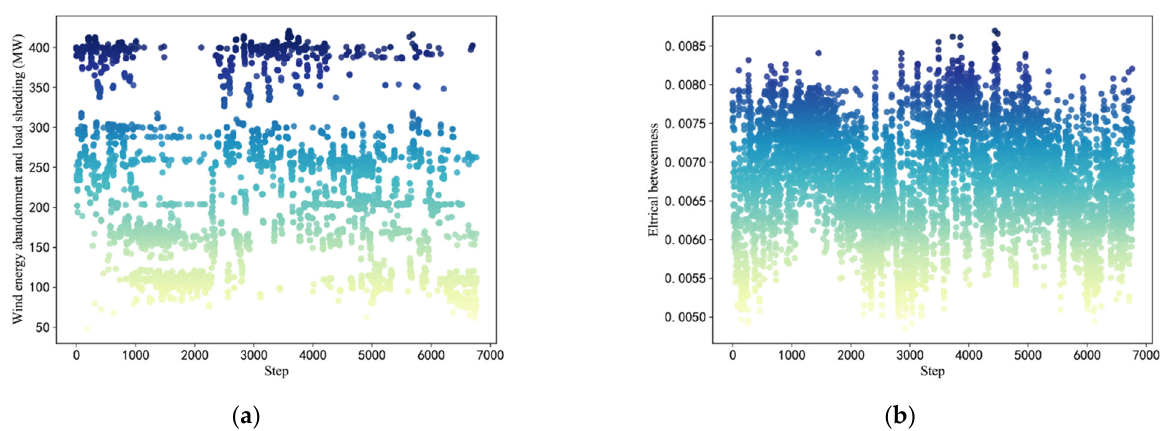
Figure 13. ( a ) Indicator of electrical betweenness in the lower-level model. ( b ) Indicators of wind curtailment and load shedding in the lower-level model.